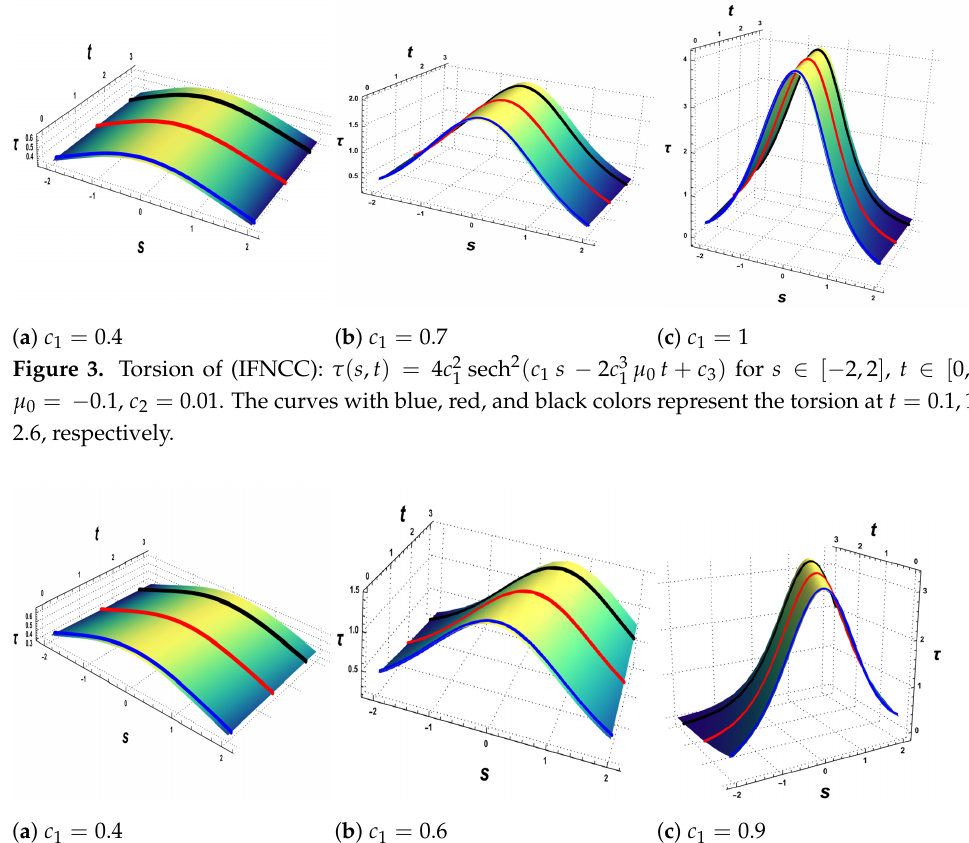
Figure 4. Torsion of (IFNCC): τ ( s , t ) = 4 c 2 µ 0 = 0.3, c 2 = 0.01. The curves with blue, red, and black colors represent the torsion at t = 0.1,1.4, 2.6, respectively.